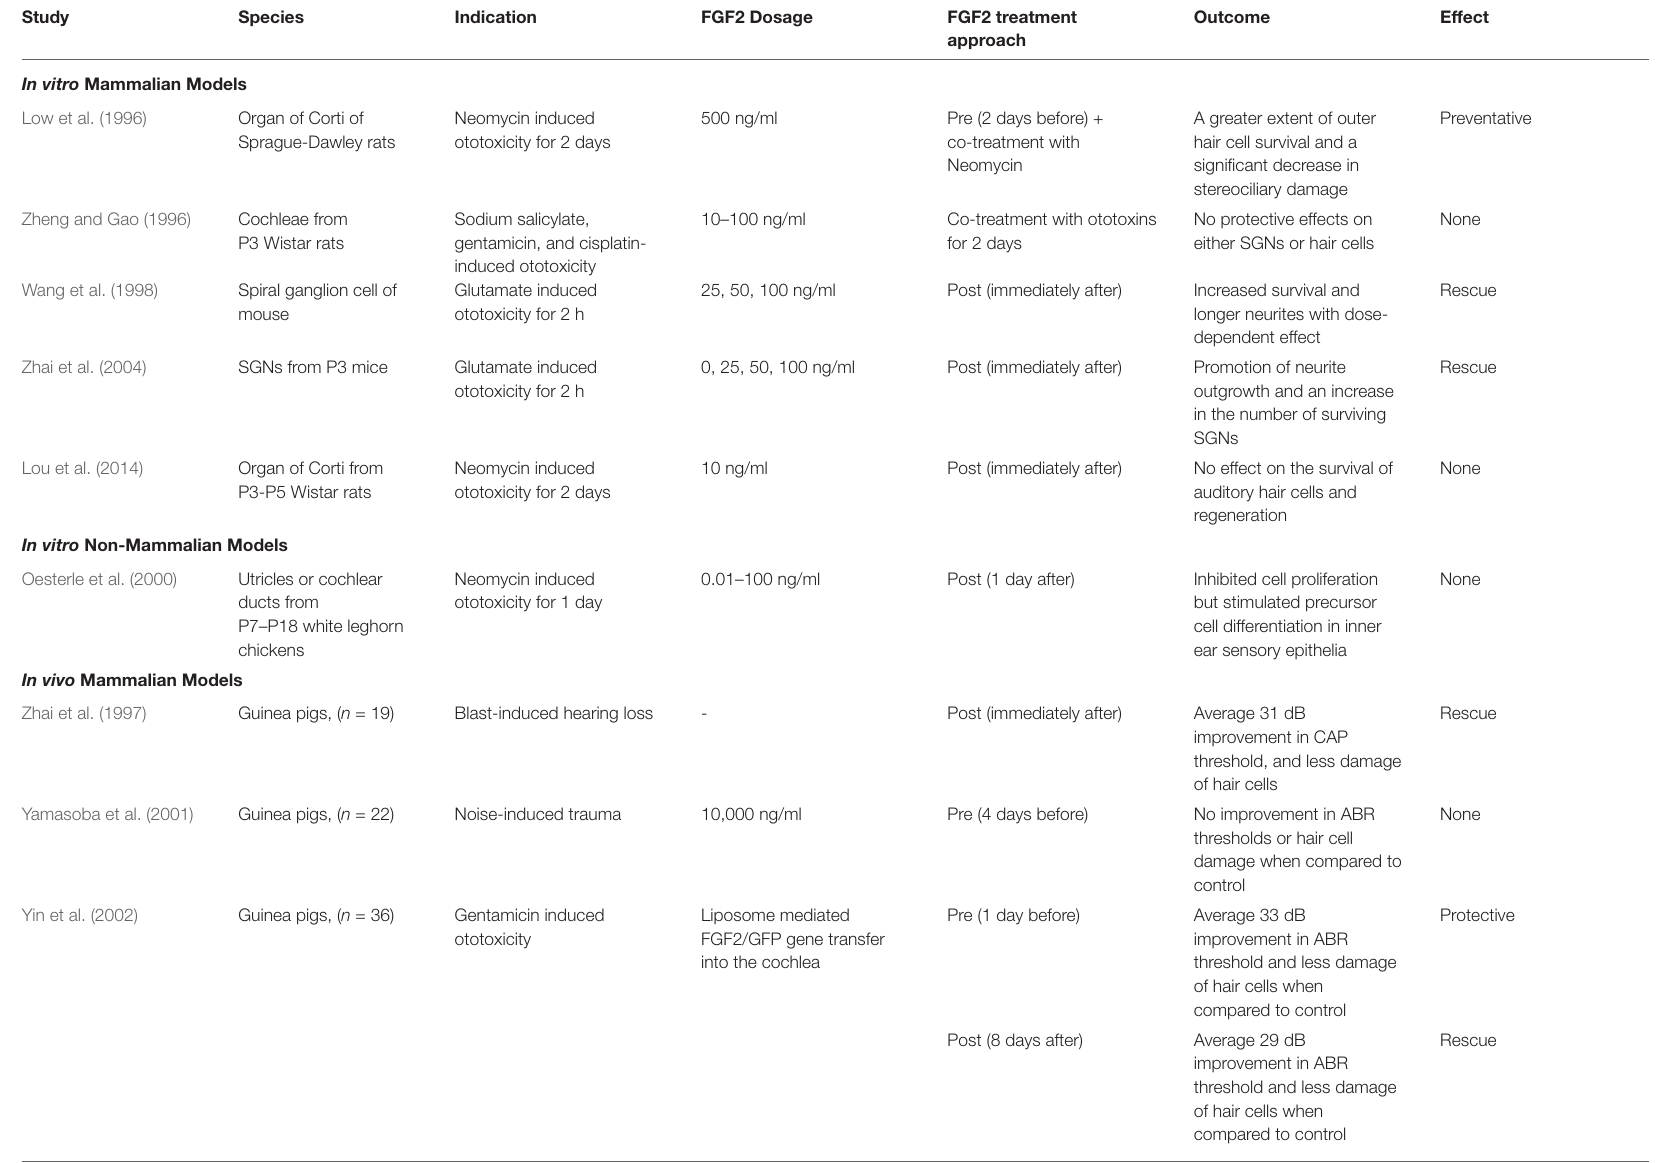
TABLE 3 | FGF2 in studies of induced auditory